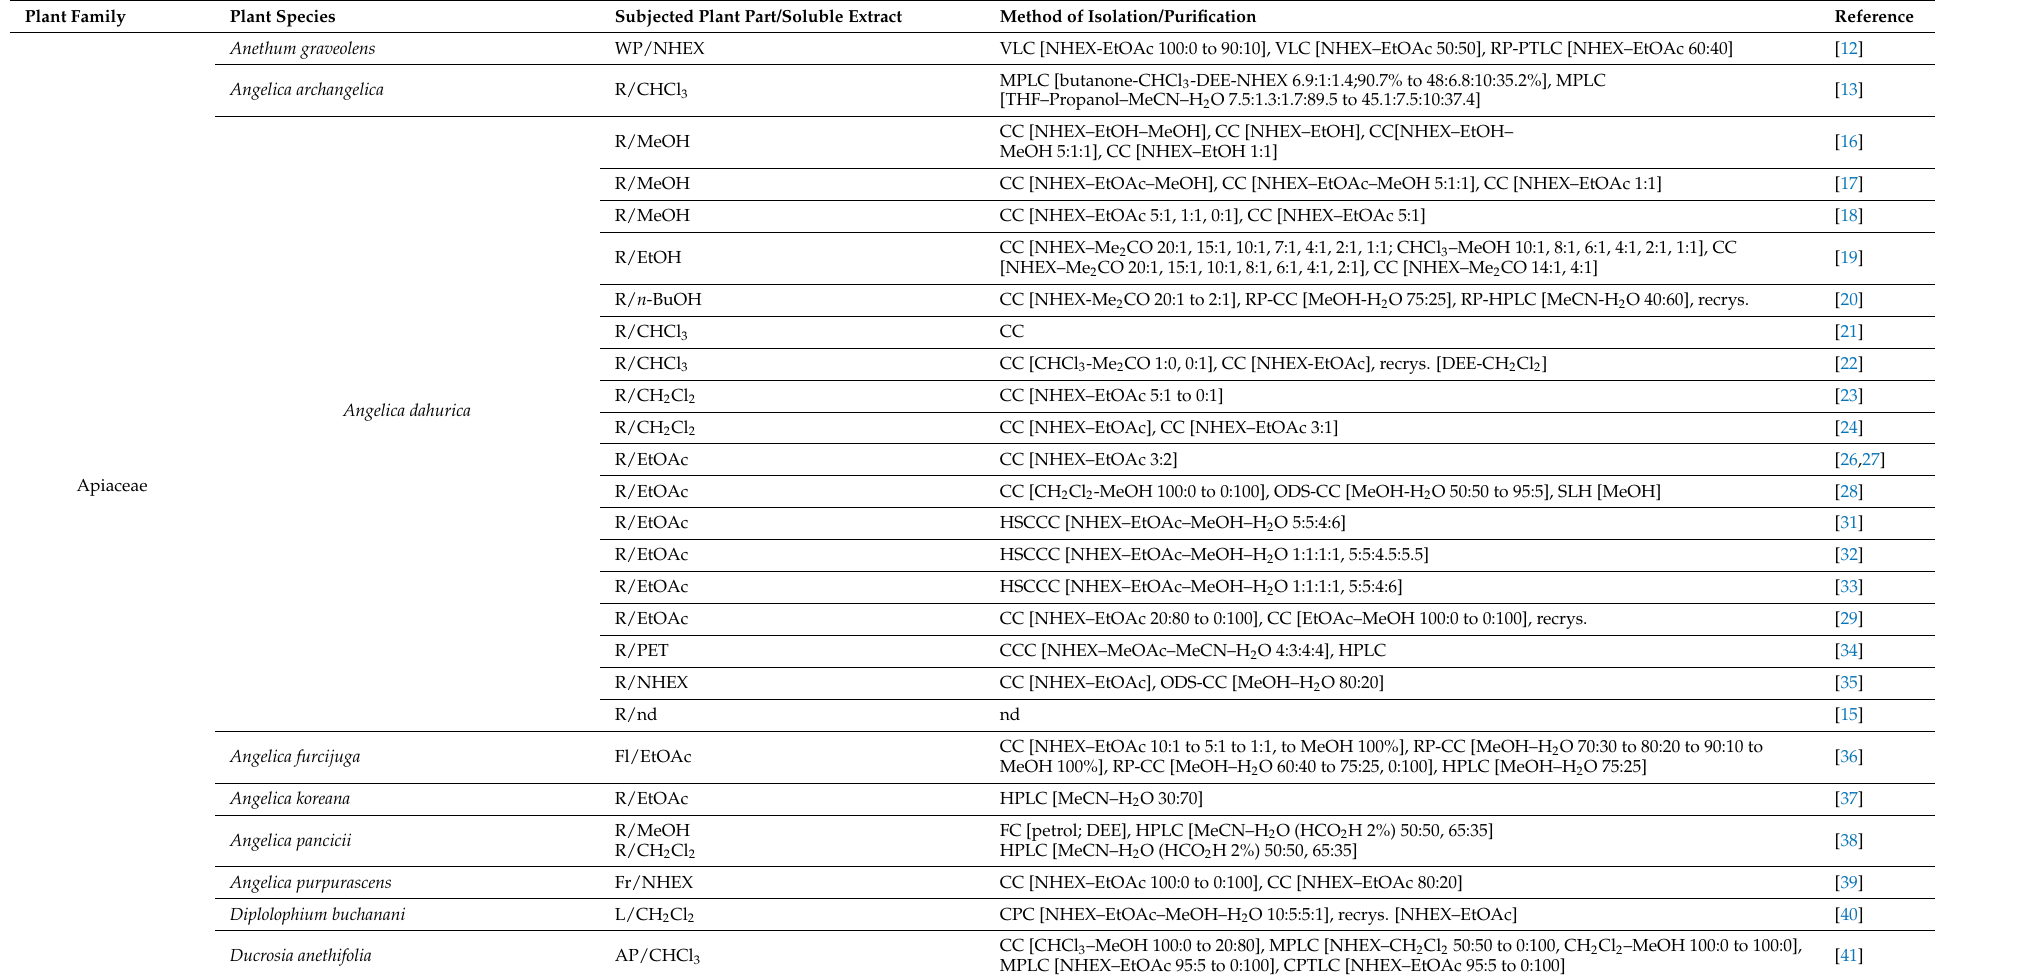
Table 1. Isolated oxypeucedanin from different plant